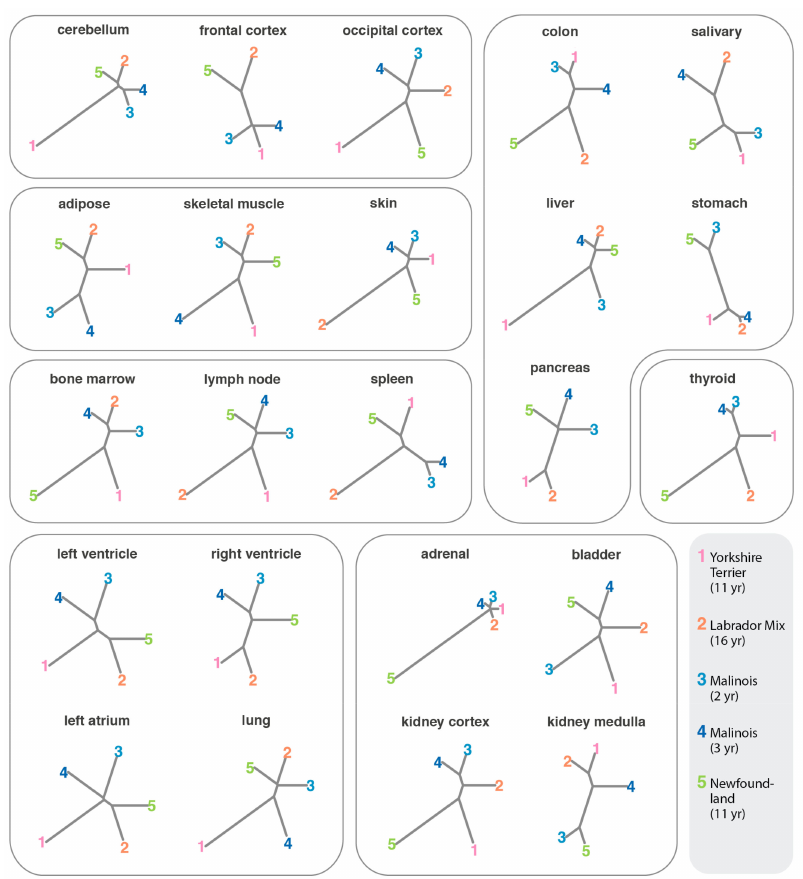
Figure 6. The relationship between samples within a single tissue type is highly variable. Clustering is based on Euclidean distances among samples, with no consistent clustering by age or breed observed. Outlines group tissues of a given